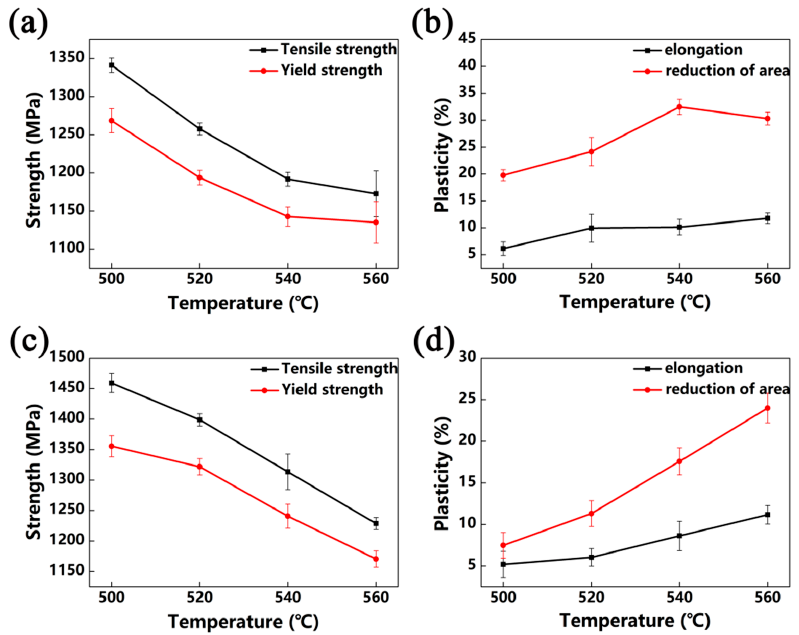
Figure 12. Tensile properties of Ti-35421 that was solution-treated at the α + β region for 1 h with 8 h aging: ( a , b ) solution-treated at 760 °C; ( c , d ) solution-treated at 780 °C.